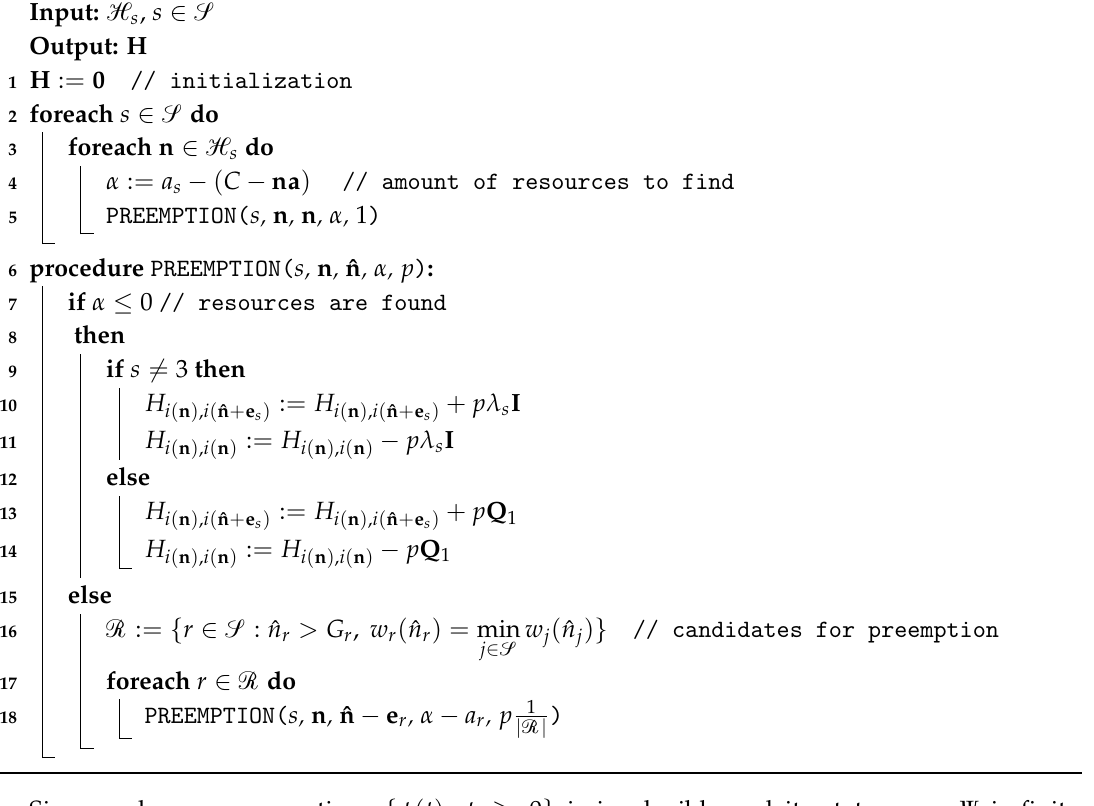
Algorithm 2: Construction of the preemption rate matrix